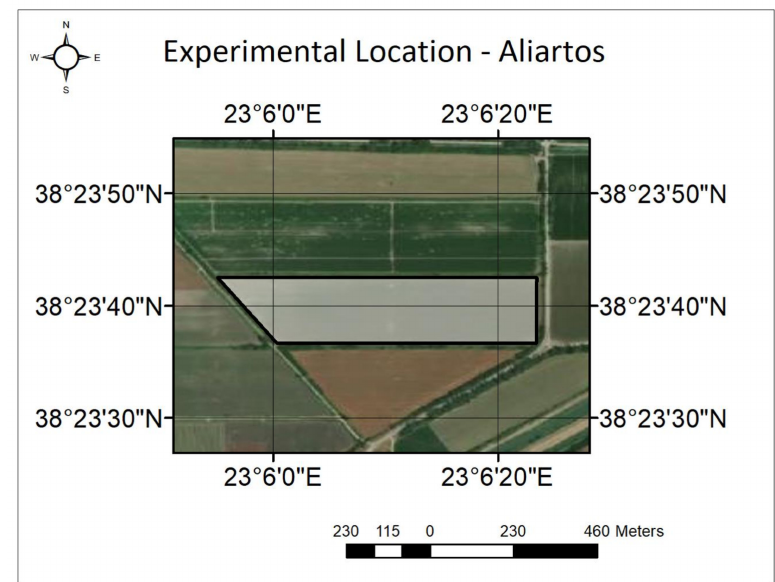
Figure 2. The experimental area for this study was located in Aliartos,